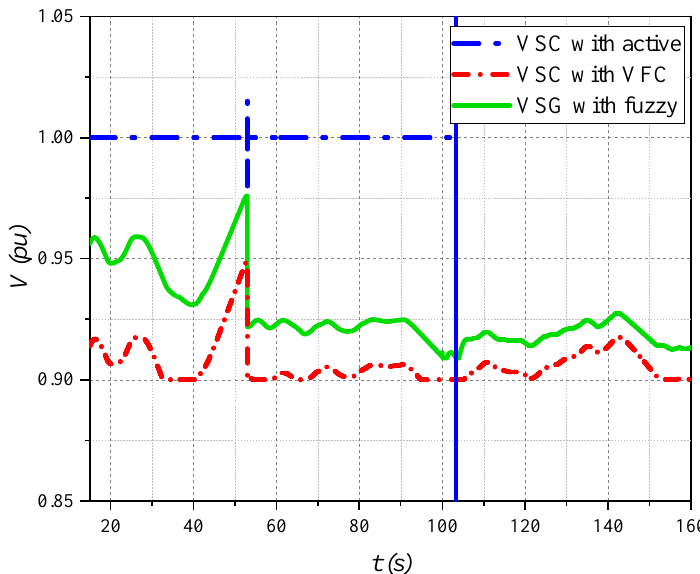
Figure 35. Voltage response of the system for the scenarios presented in Section 4.3.